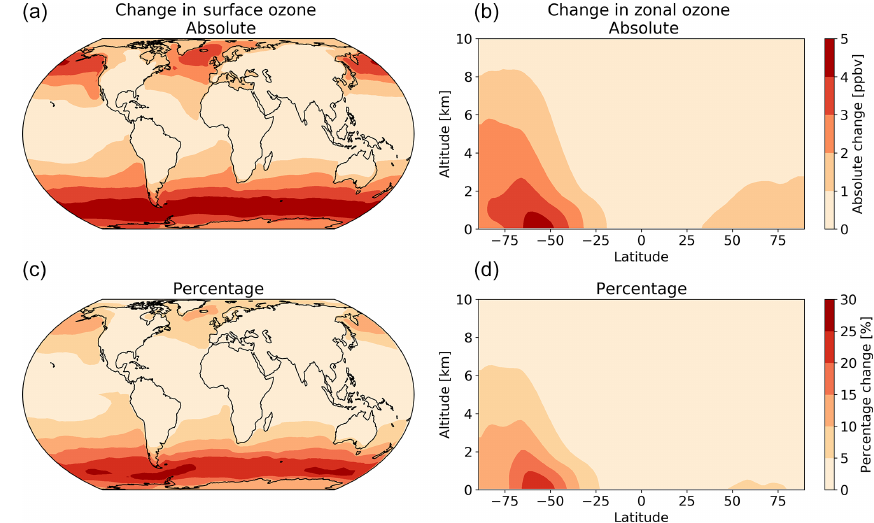
Figure 7. The annual absolute (a, b) and percentage (c, d) change in surface and column ozone mixing ratios for 2014 between the model using the default (constant) and new (variable) parameterization for r c . The largest changes occur in the surface levels of the model, especially in higher latitudes, with the Southern Ocean boundary layer representing the area experiencing the most annual average change between the two model runs.